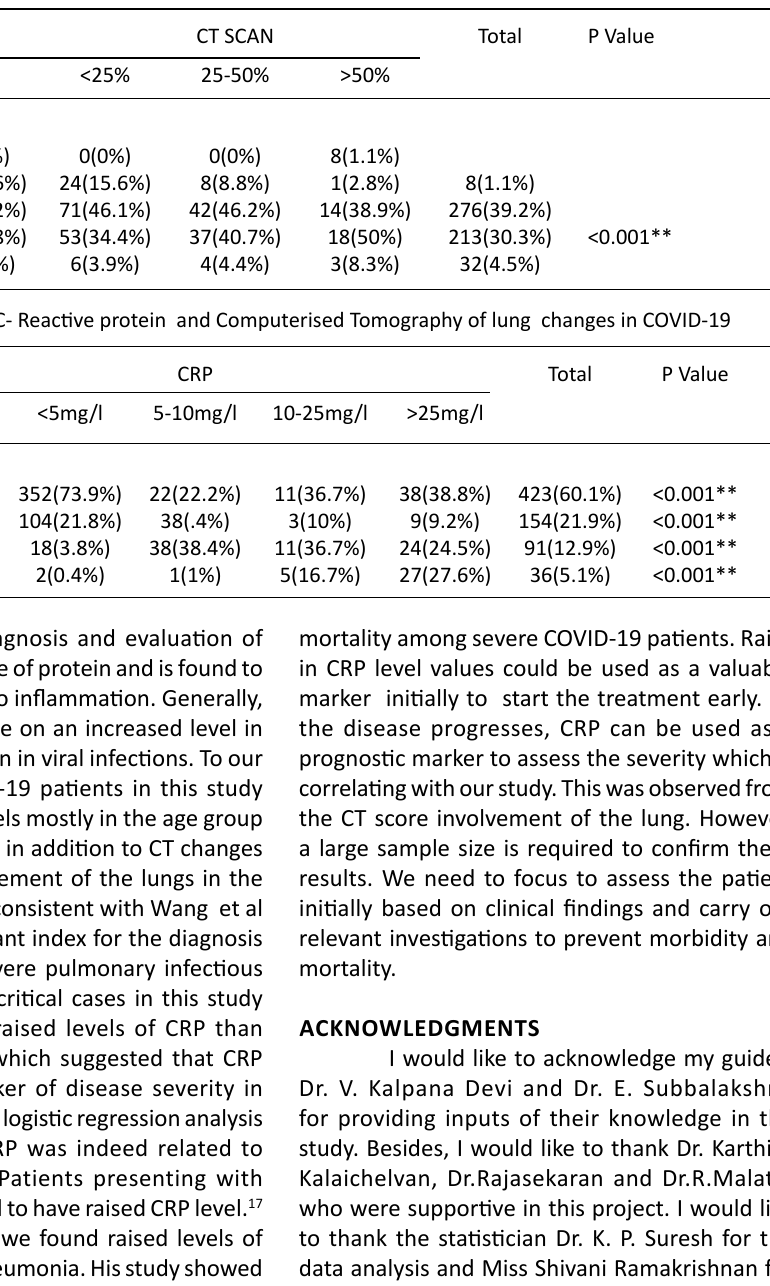
Table 5. Computerised Tomography Scan of lung Changes in different age groups Variables CT SCAN